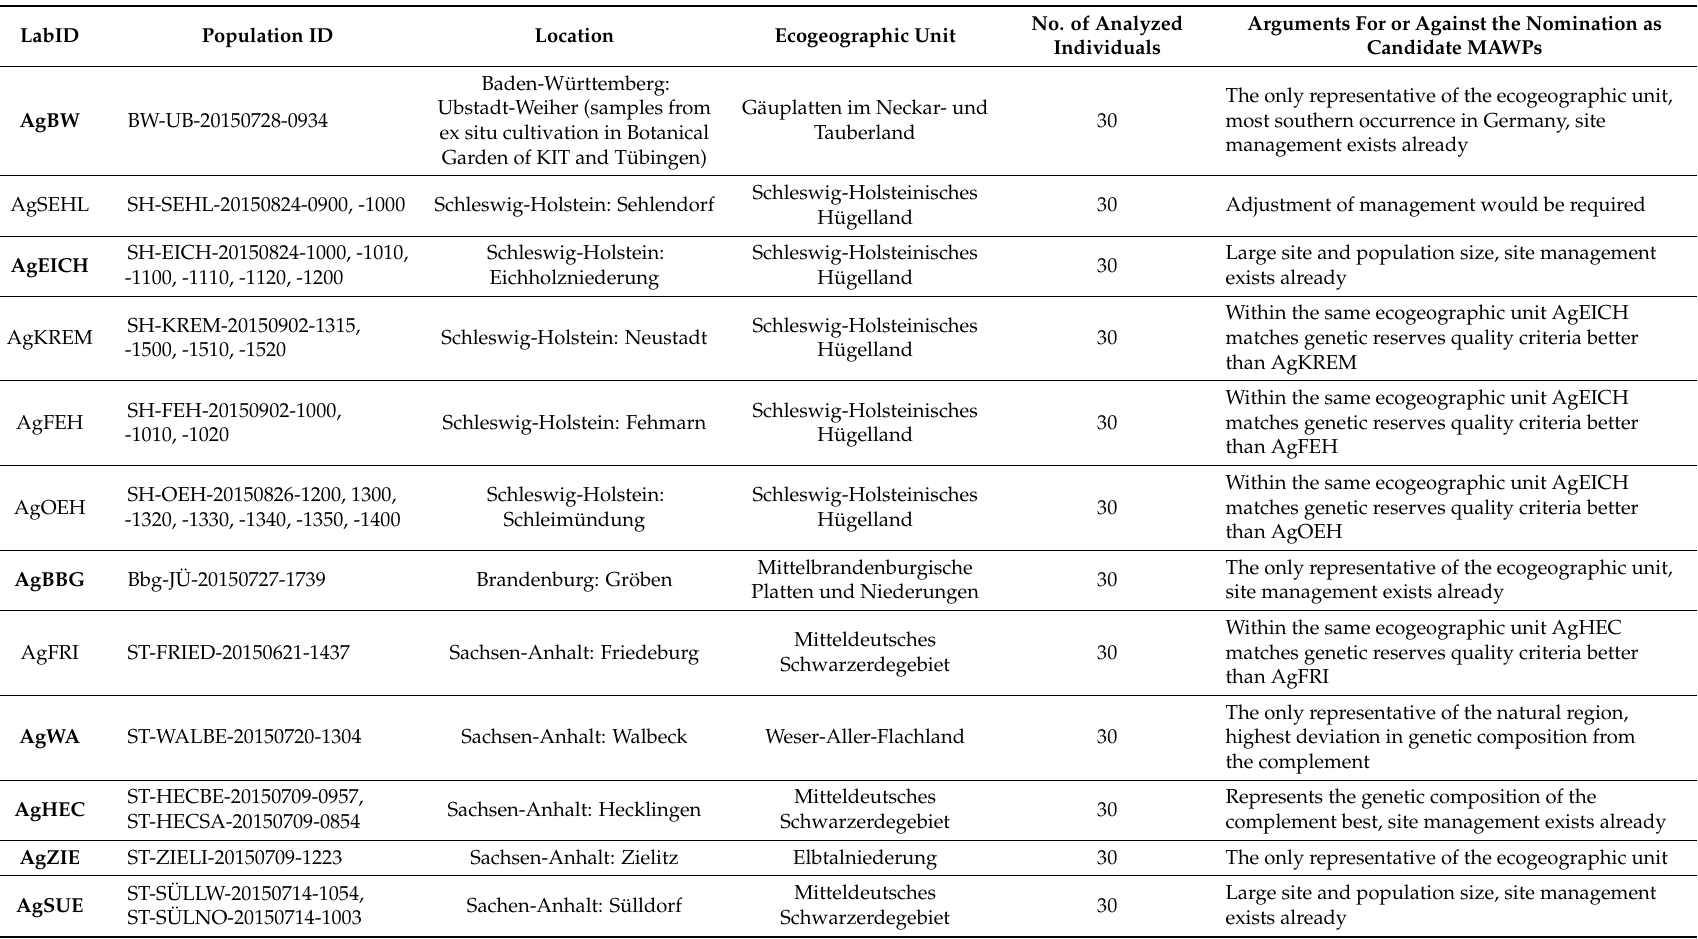
Table 1. Geographic origin of 27 occurrences of Apium graveolens sampled in Germany. The laboratory and population identifier as well as the number of plants analyzed with 16 SSR markers is presented. The term ecogeographic unit relates to the German term “Naturraum 3. Grades” [42]. The laboratory identifiers in bold letter type mark Most Appropriate Wild Populations (MAWP). Arguments for and against the MAWP nomination are given in the last